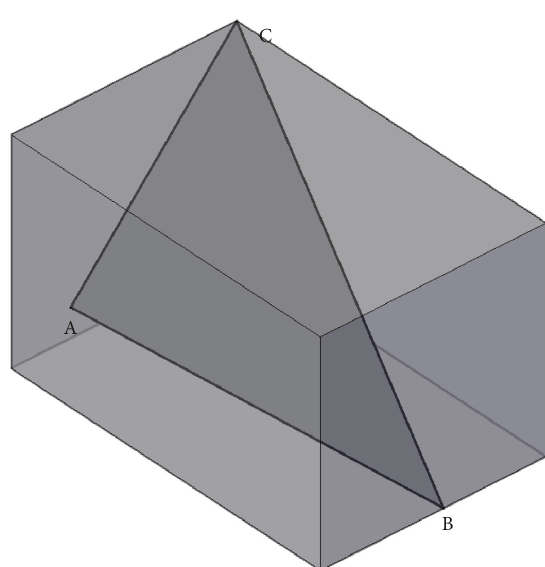
Figure 12: The smallest cube contained triangular patch.